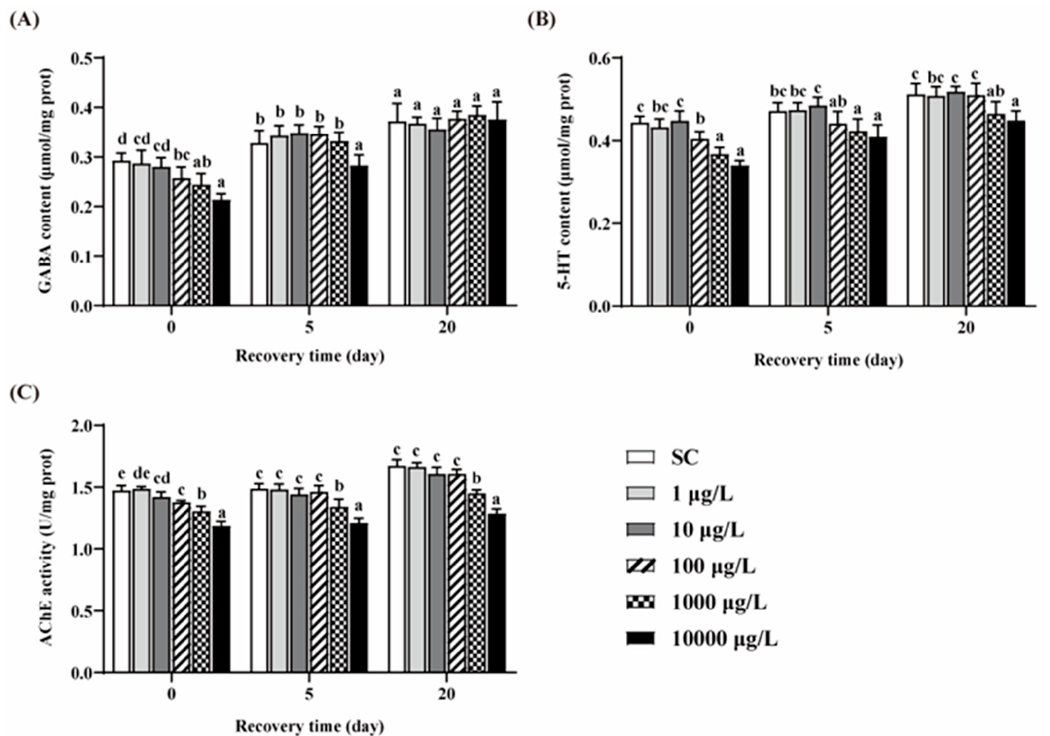
Figure 5. GABA ( A ) and 5-HT ( B ) contents, and AChE ( C ) activity of zebrafish. One-way ANOVA followed by Tukey’s post hoc tests were used to determine statistical differences. Different letters indicate significant differences between different treatment groups at the same time ( p < 0.05).